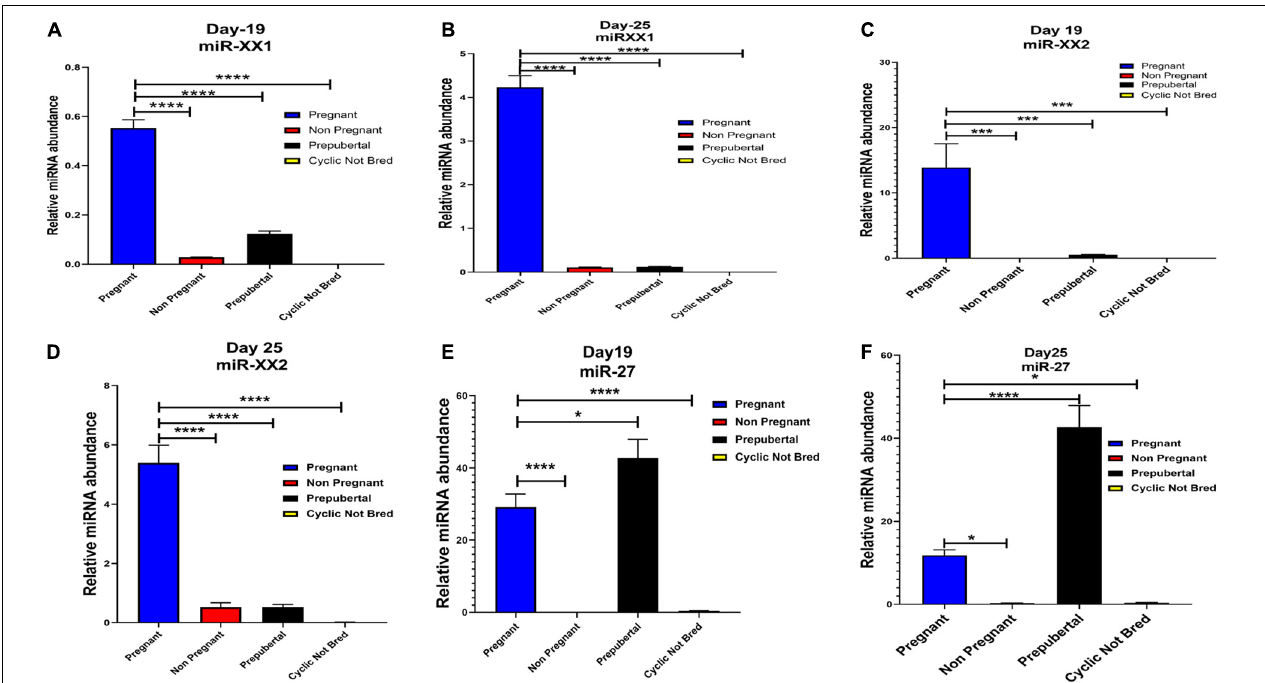
FIGURE 6 | Graphical representation of the abundance of miR-XX1, miR-XX2, and miR-27 in the blood plasma of pregnant, non-pregnant, prepubertal, and cyclic heifer not bred at Day 19 and Day 25 of pregnancy. Here, X axis represents the relative miRNA abundance and Y axis represent the experimental group of animals where blue, red, black and yellow column represents pregnant, non-pregnant, prepubertal and cyclic not bred animals. * p < 0.05, *** p < 0.001, **** p < 0.0001.